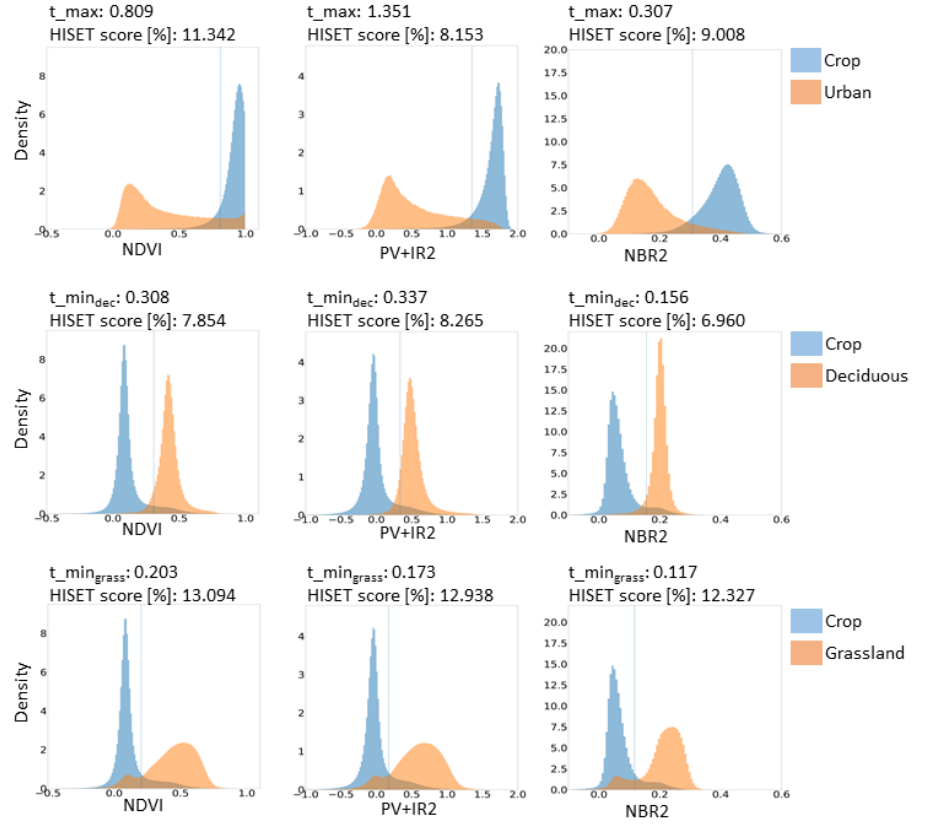
Figure 5. Density plots showing the spectral-temporal variability and separability of certain LC types in the complete test site measured by three spectral indices (NDVI, PV+IR2 and NBR2). LC types are agricultural fields (crop), deciduous forests/trees (deciduous) and grasslands (grassland), which build the basis for the threshold